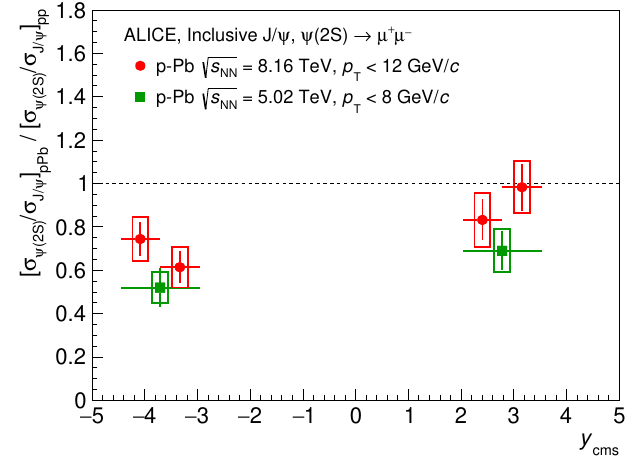
Figure 10 . Double ratio of (2S) and J/ cross sections in p-Pb and pp collisions as a function of p rapidity, at s NN = 8 : 16 TeV, compared with the corresponding results at The error bars represent the statistical uncertainties, while the boxes correspond to uncorrelated systematic